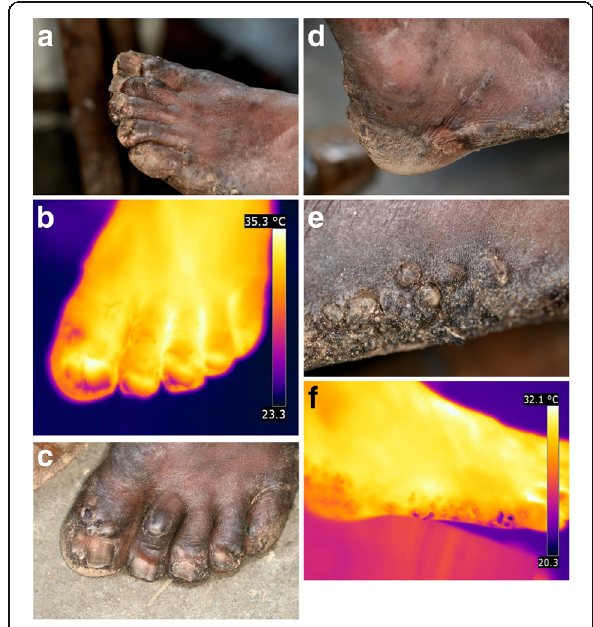
Fig. 3 ( a ) left foot with hyperkeratosis und desquamation presenting lesion in all stages. ( b ) left foot, hyperthermia of the whole foot except for the areas corresponding to uplifted nails (iron toe. ( d ) right foot, viable lesions hidden under hyperkeratotic skin. ( e ) right foot, extensive inflammation and hyperkeratosis of the